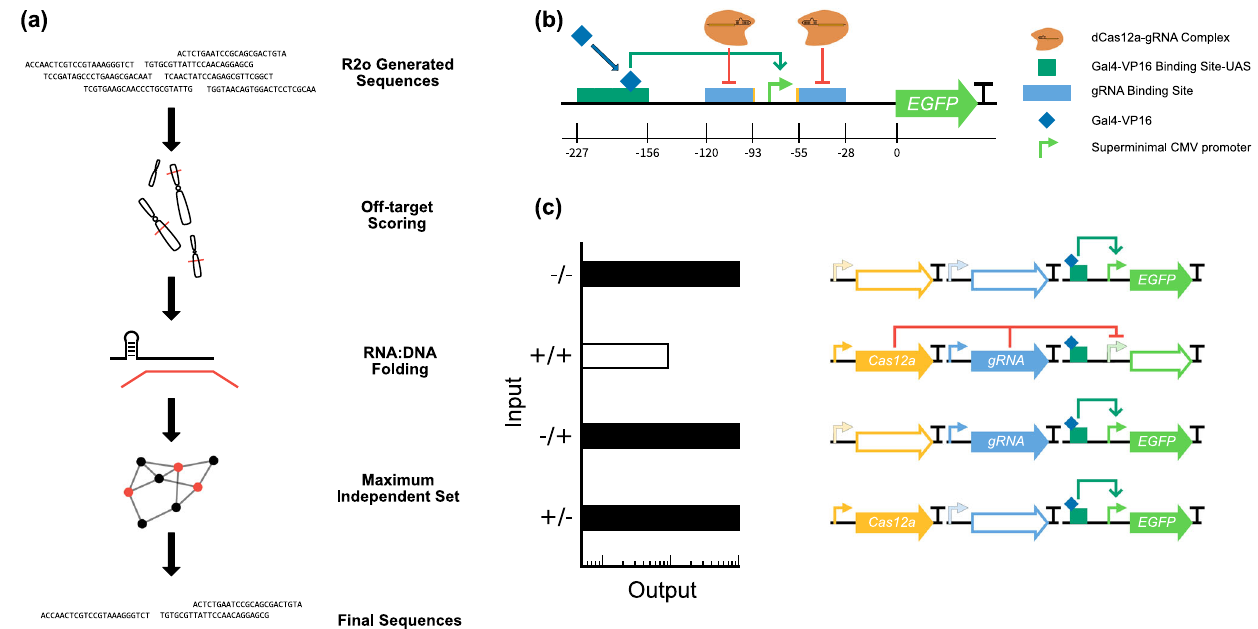
Fig. 2 gDesigner pipeline, promoter architecture and system dynamics. a Initial sequences are generated using the R2oDNA Designer method. The sequences are subsequently fi ltered through the gDesigner pipeline (https://github.com/jmacdona/gDesigner) to remove sequences with predicted off-target sites, binding af fi nities outside a speci fi ed range, selecting a fi nal set of orthogonal sequences with minimal predicted cross-interactions. b Schematics of the promoter architecture. Gal4-VP16 activates the expression of EGFP, while the binding of Cas12a-gRNA controls its repression. 23 bp gRNA-binding sites with their PAM sequences (5 ’ -TTTN-3 ’ ) fl ank the smCMV promoter. The 5 ’ binding site is directly adjacent to the TATAA box, and 36 bp downstream the UAS. The 3 ’ binding site is placed 10 bp downstream of the transcription start site (TSS) and 105 bp downstream of UAS. c Schematics of the predicted NAND logic gate. EGFP expression is repressed in the presence of hdLbCas12a/gRNA-promoter